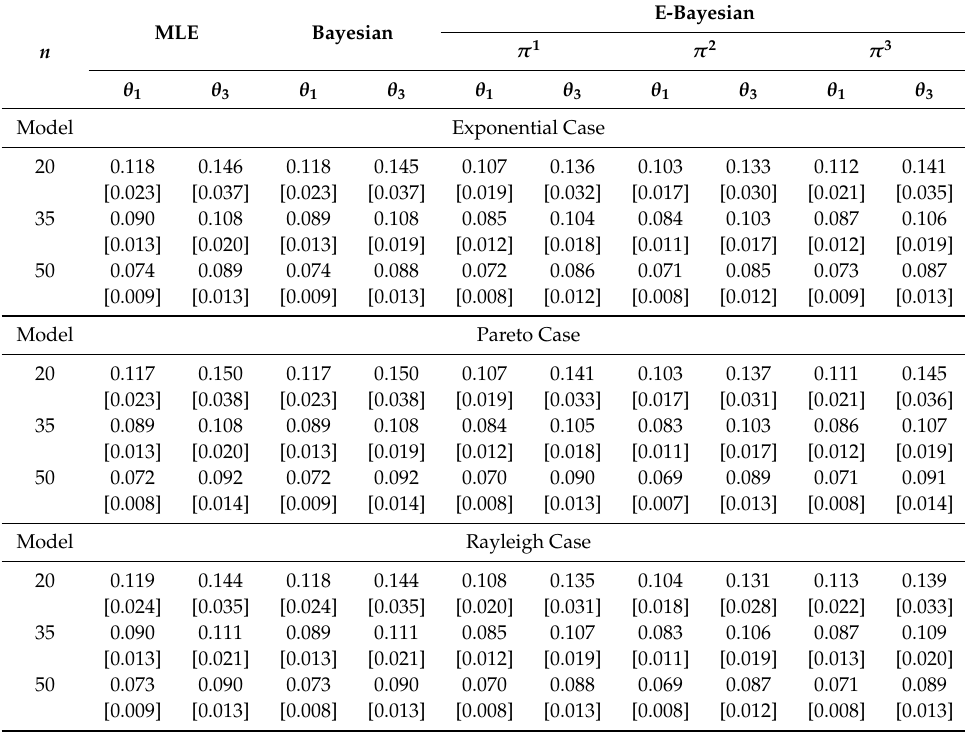
Table 6. The AB and MSEs (within bracket) of point estimates with ( c 1 , c 2 , c 3 ) = ( 3,2.5,2 )